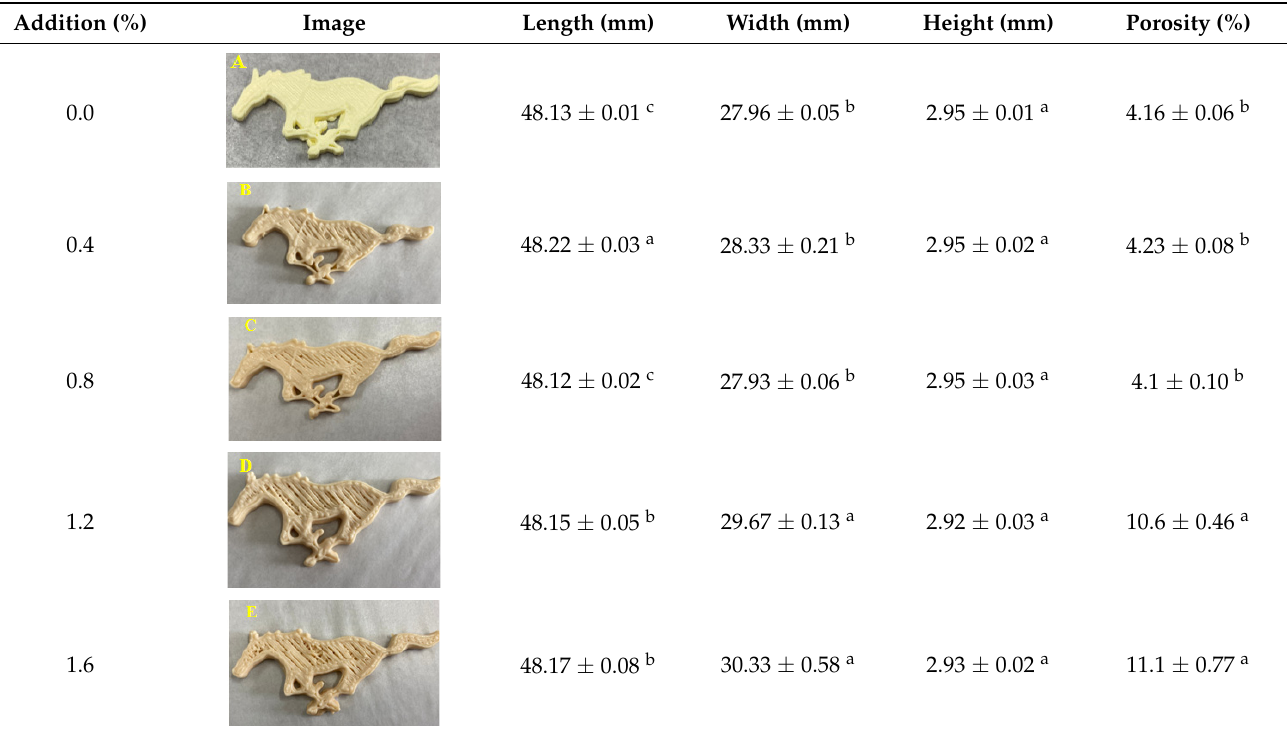
Di ff erent le tt ers in the same line indicate signi fi cant di ff erences between values ( p < 0.05). The e ff ect of apple polyphenols on the color of the 3D-printed processed cheese sam- ples is shown in Table 2. The addition of apple polyphenols had a signi fi cant e ff ect on the sample color ( p < 0.05). Speci fi cally, apple polyphenol addition resulted in lower L* and b* values but higher a* values, indicating that the samples became less bright, darker, and more yellow in color, and these changes were positively correlated to the polyphenol con- tent. Table 2. Color analysis of 3D-printed processed cheese with di ff erent apple polyphenol content. Addition (%) L* 0.0